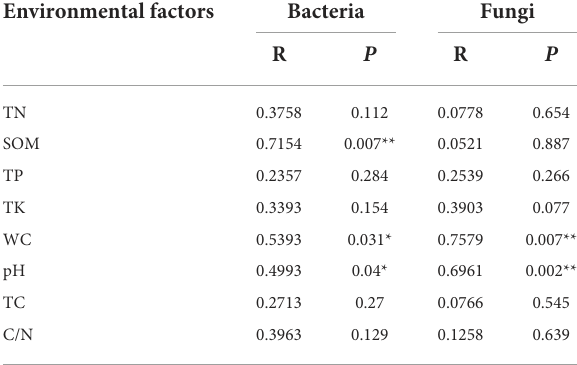
TABLE 2 Correlation between microbial communities and environmental